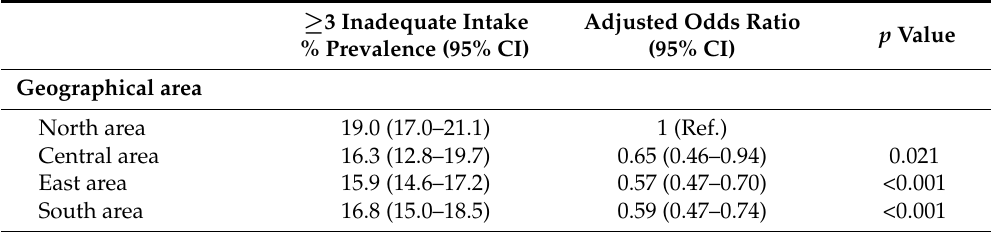
Table 5. Multivariable logistic regression model for inadequate intake of 3 or more out 6 micronutrients according to geographical